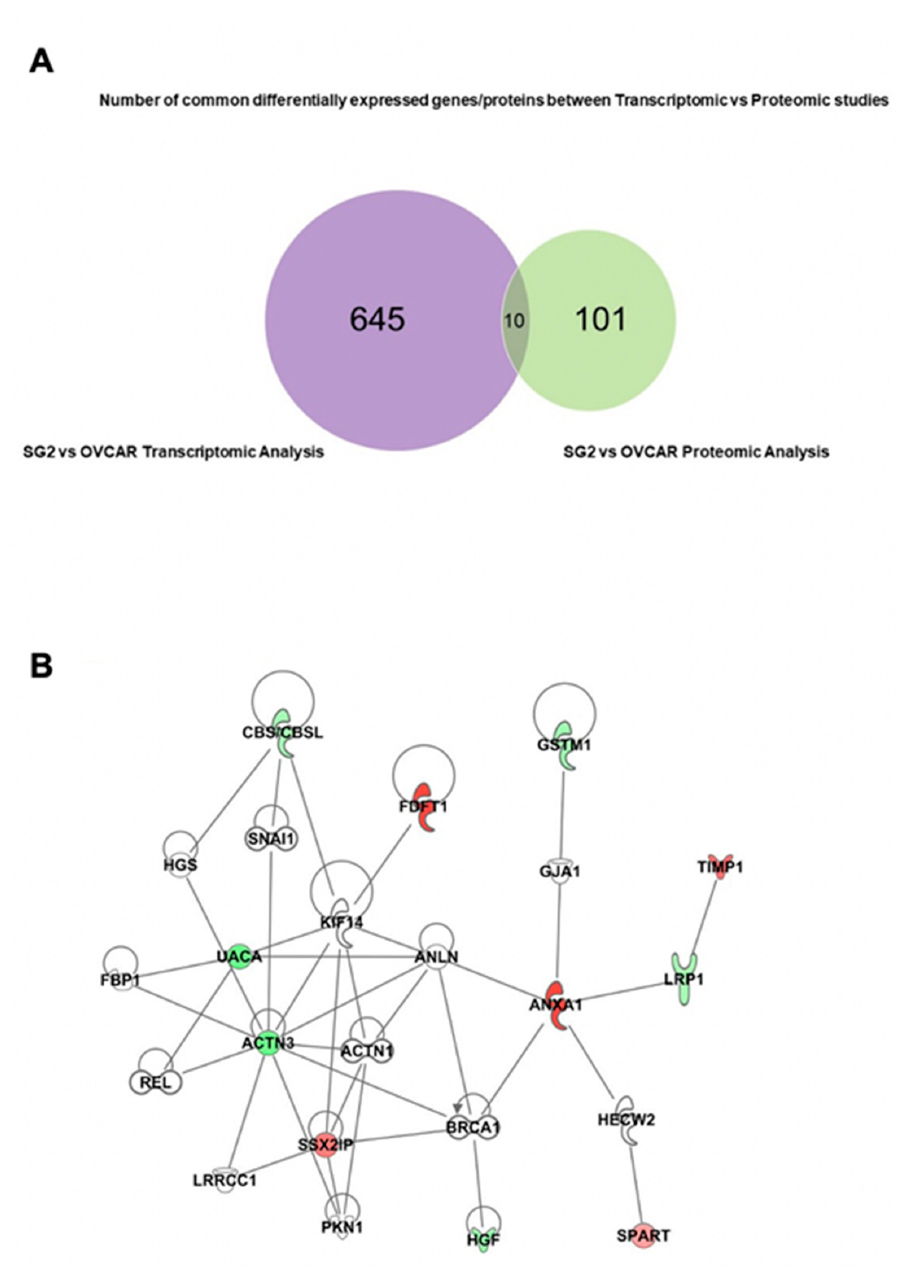
Figure 6. Common RNA transcripts and proteins deregulated following RBPMS knockout: ( A ) Venn diagram showing that 655 RNA transcripts and 111 proteins were differentially abundant in SG2 and EV clones. Only 10 genes were common at the RNA and protein levels in the RNAseq and proteomic studies. ( B ) A canonical pathway showing the interaction between the 10 common genes identified via RNAseq and proteomics studies. Red color denotes upregulated and green denotes downregulated genes.